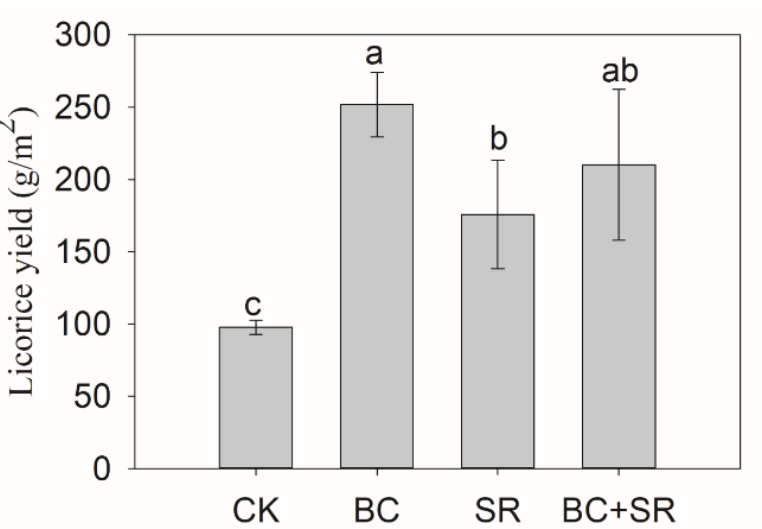
Figure 1. Effect of different soil types on licorice yield. CK, sand only; BC, biochar; SR, sand and soft rock; BC + SR, sand, biochar, and soft rock. Data are shown in mean ± SD. Different letters indicate significant differences ( p < 0.05).